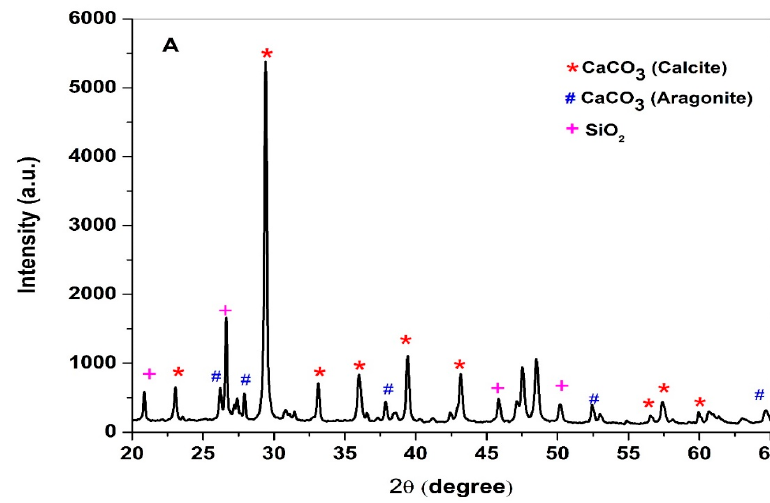
Figure 3. X-ray diffraction pattern for sample A.